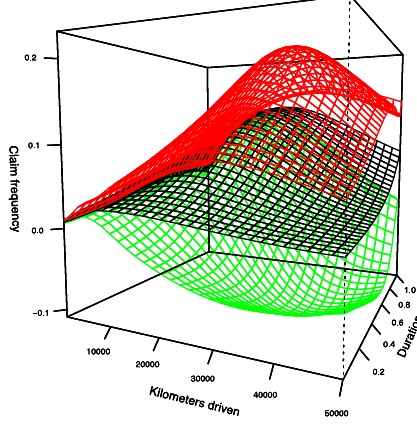
Risks 2017 , 5 , 54